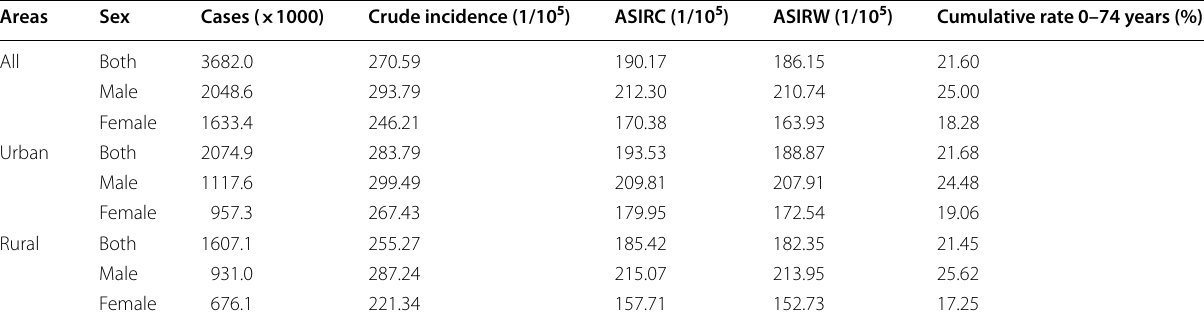
Table 1 Estimated cancer incidence in China in 2013. This Table was published previously and is reproduced with permis- sion from China Cancer [1]